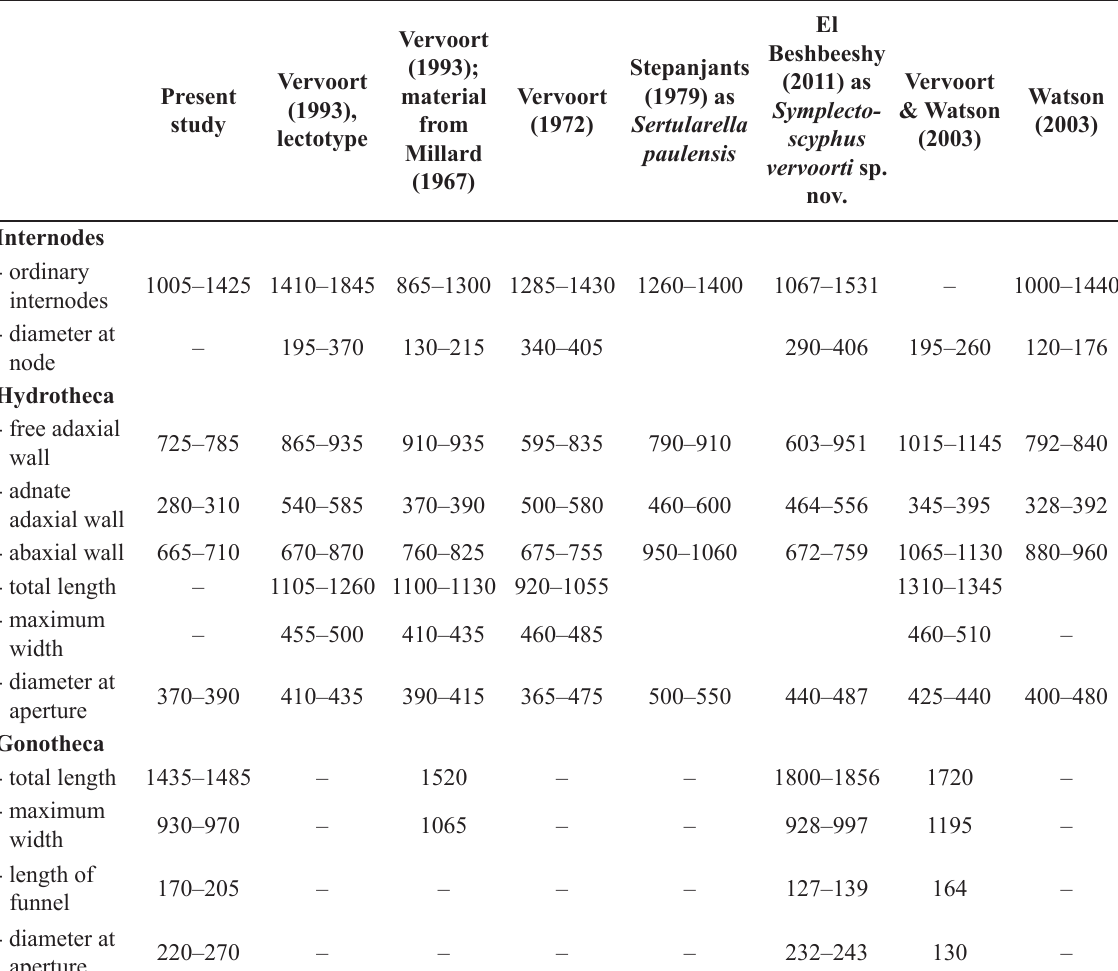
Table 11. Measurements of Symplectoscyphus paulensis Stechow, 1923 from various sources,